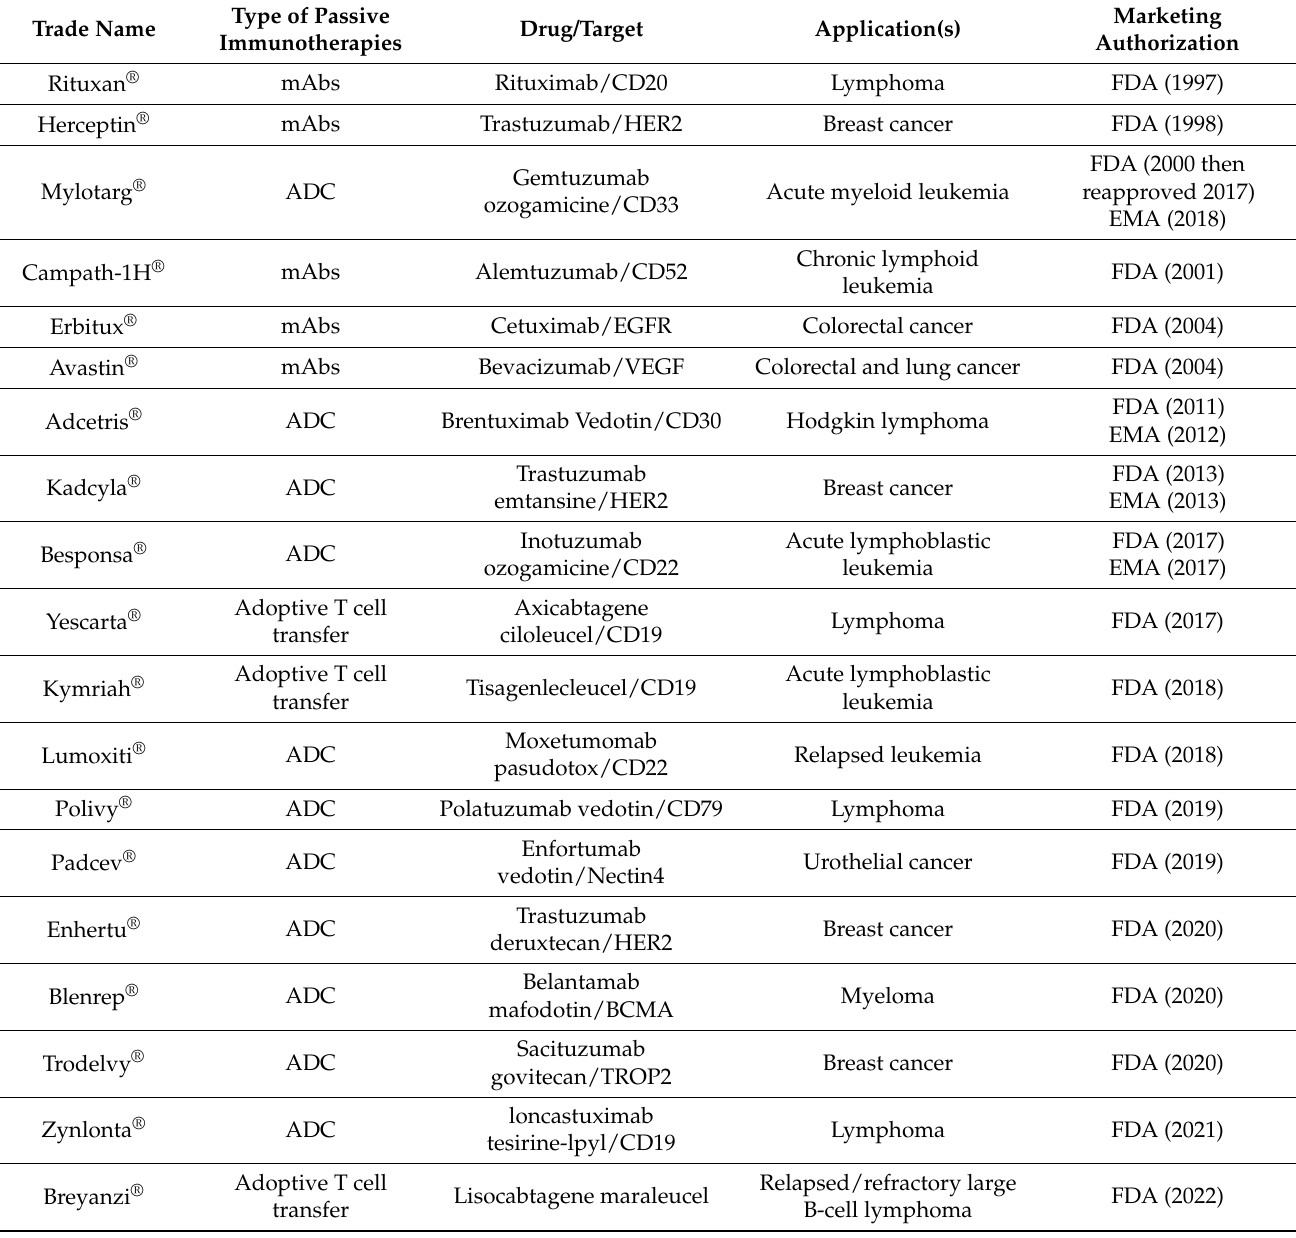
Table 2. Anticancer passive immunotherapies currently approved by the FDA and/or